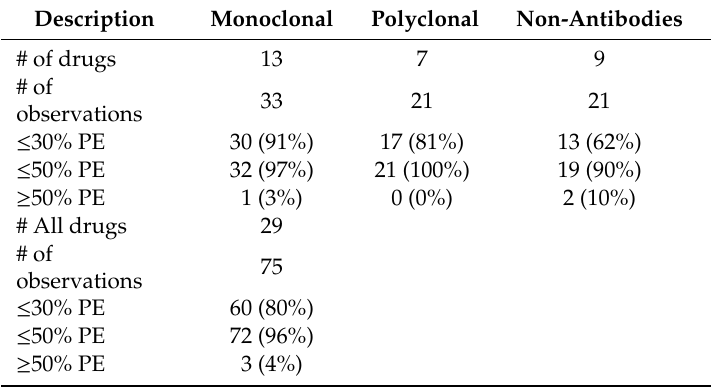
Table 4. Summary statistics of the analysis by the age dependent exponents (ADE) model.